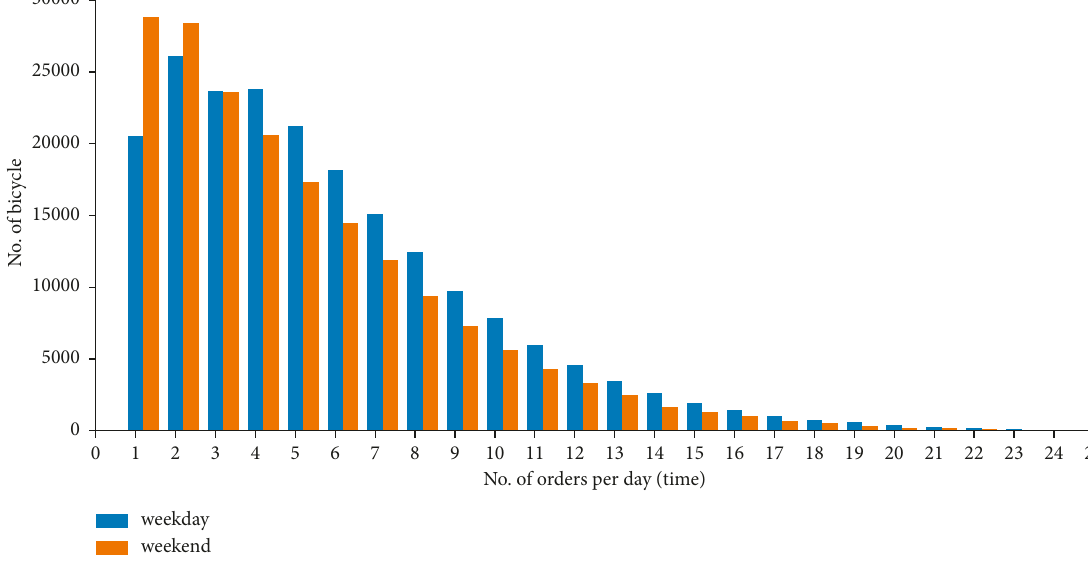
Figure 7: The distribution of the daily turnover rate of active bicycles.